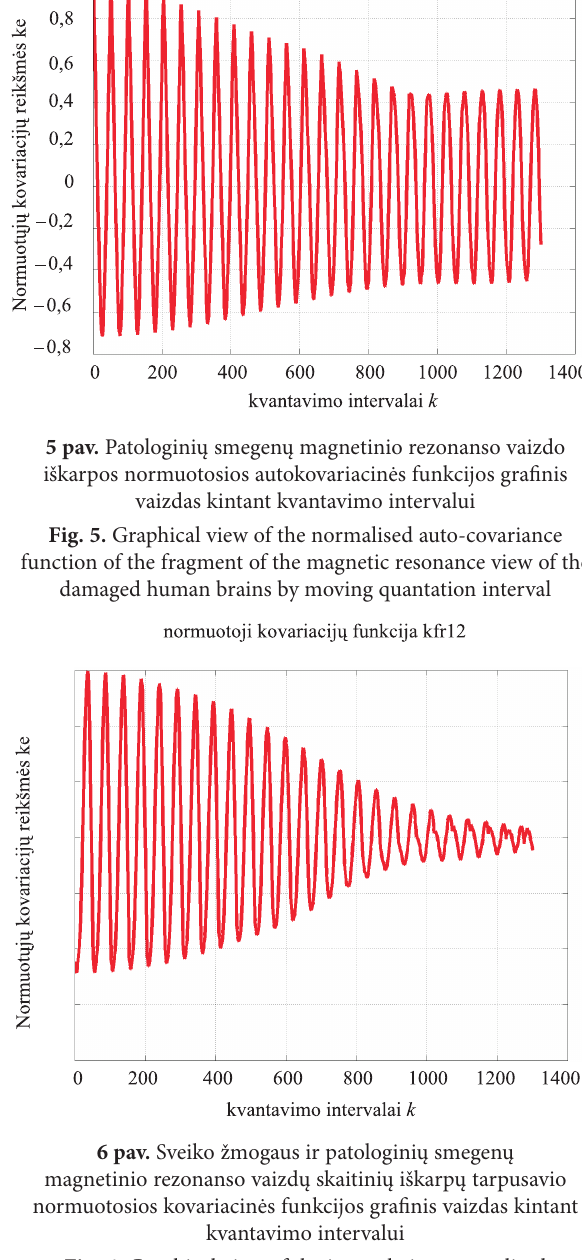
Fig. 6. Graphical view of the interrelation normalised covariance function of the fragments of the magnetic resonance views of the healthy and damaged human brains by